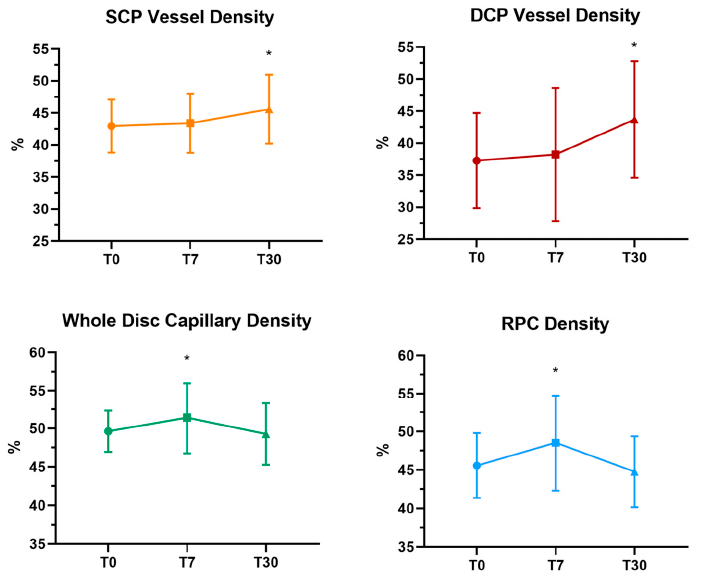
Figure 3. Column bar graphs showing the variation of study parameters at all follow ups (T0, T7, T30). Values are presented in mean ± standard deviation. SCP = superficial capillary plexus; DCP = deep capillary plexus; RPC = radial peripapillary